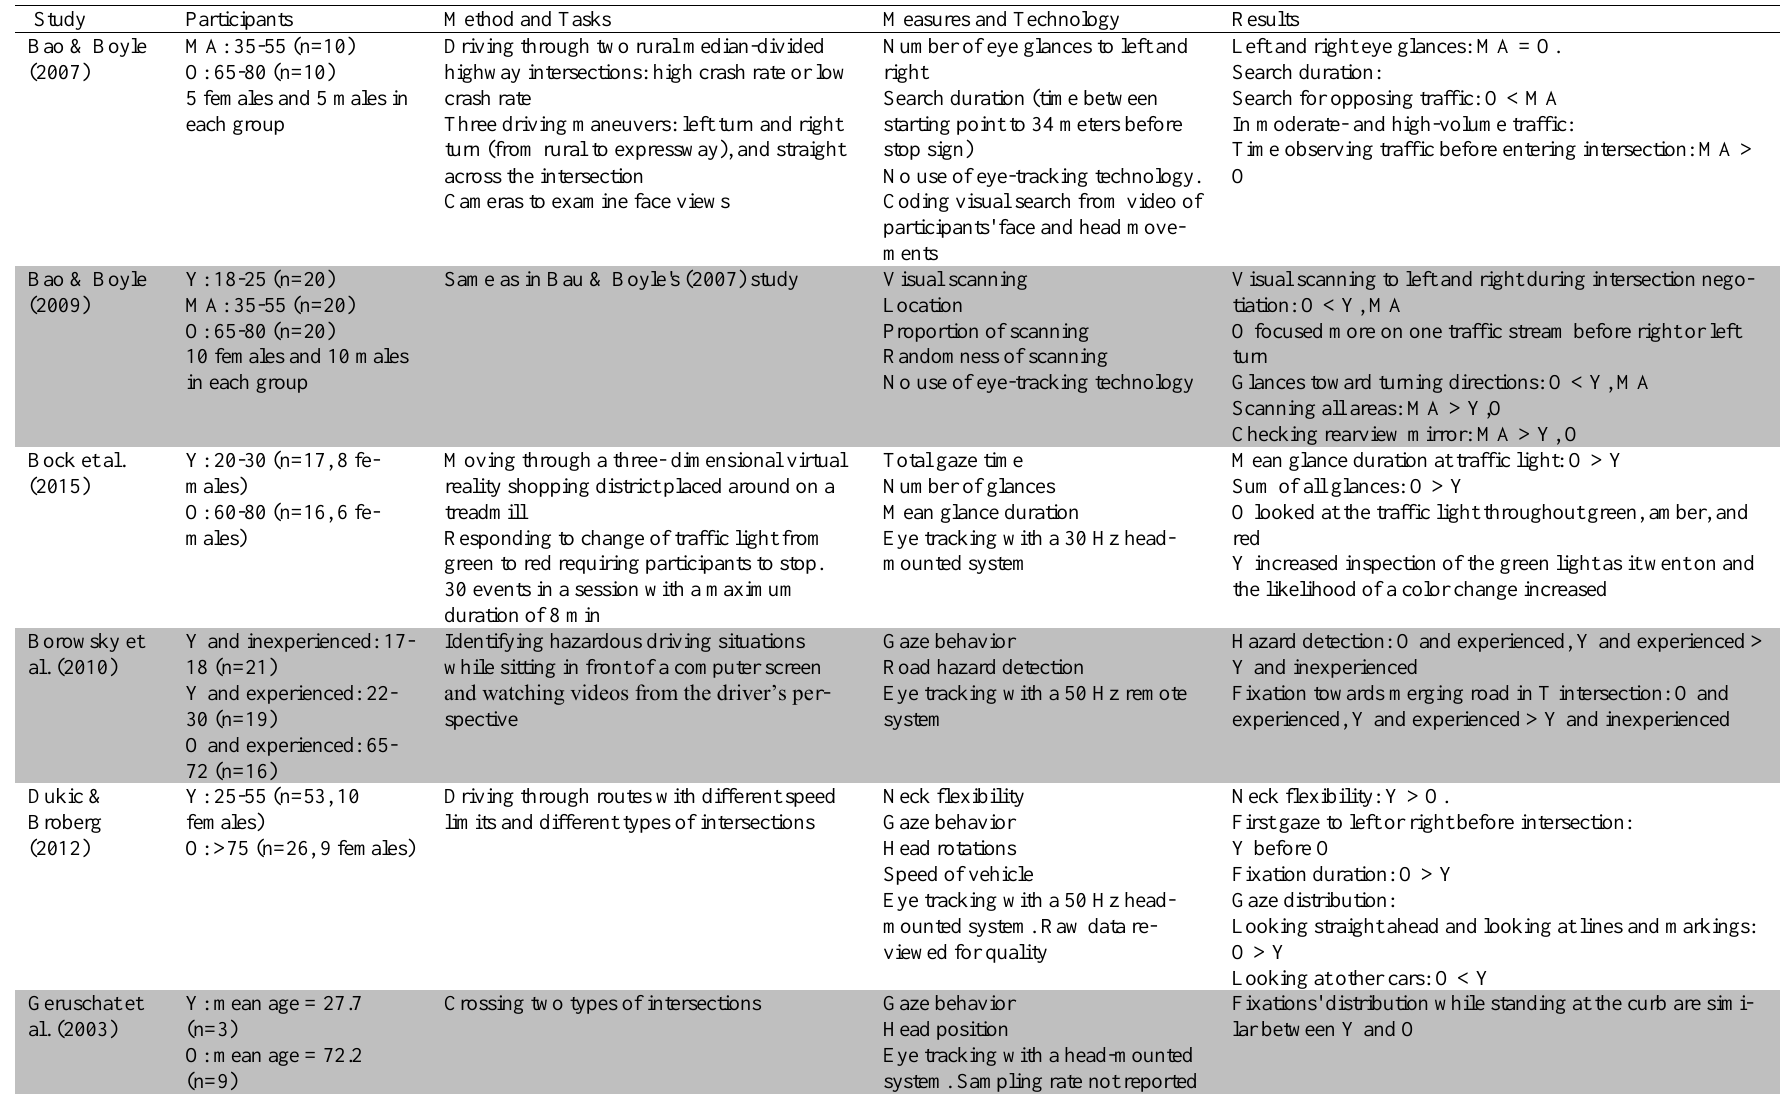
A Summary of Studies (N = 23) Examining the Effect of Age on Gaze Behavior in Drivers and Pedestrians (the studies are presented in alphabetical